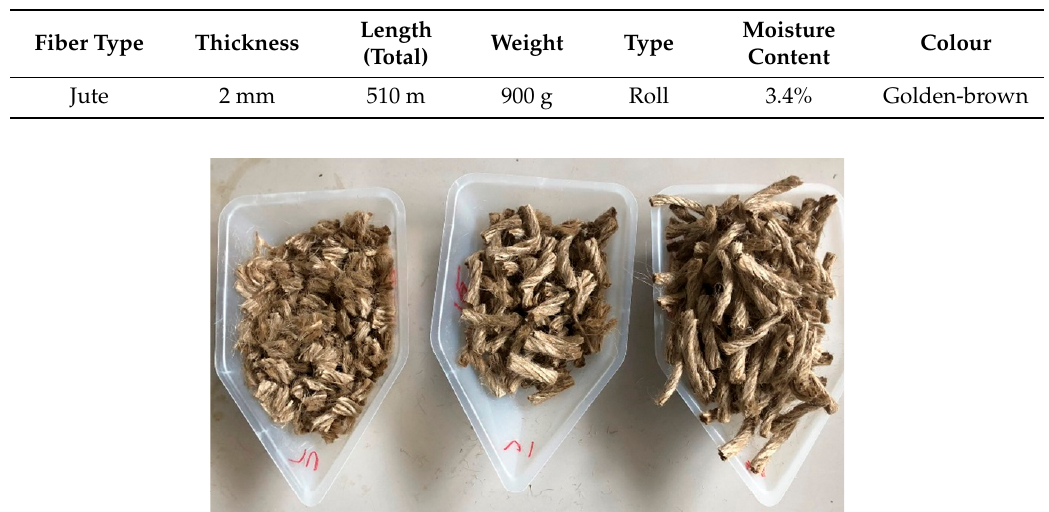
Table 1. The key features of the jute fibers used in this study.